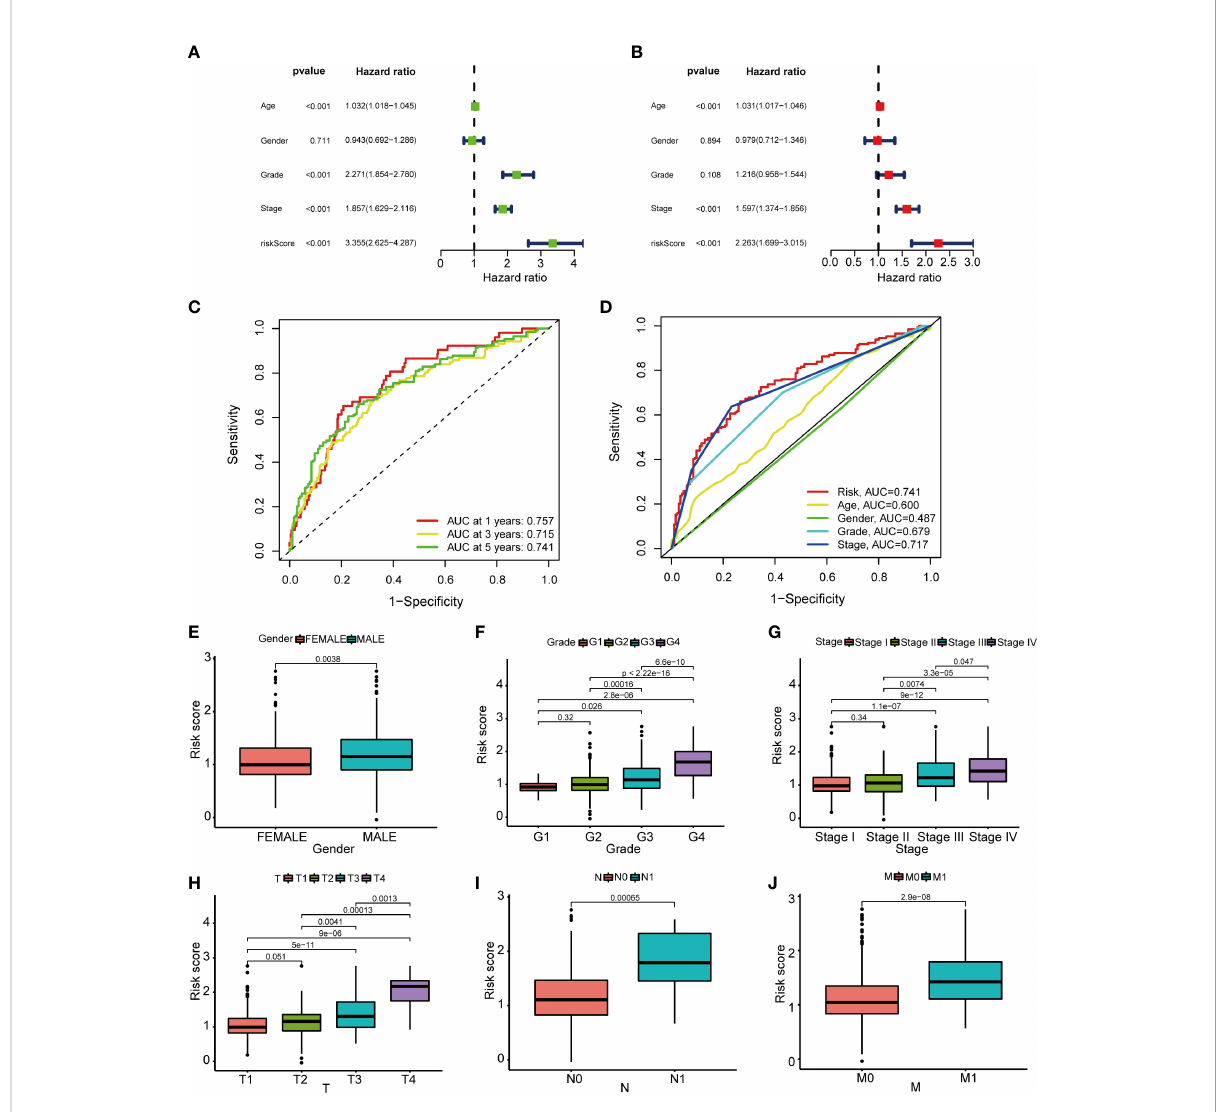
FIGURE 5 The prognostic value of the basement membrane score combined with pathological features in the TCGA cohort. (A, B) . The multi-Cox-reg and uni-Cox-reg analyses of the risk score and clinical variables in association with overall survival. (C, D) . The 1-, 3-, and 5-year ROC curves were plotted to indicate the association of the risk scores with clinical characteristics. (E – G) . The relationship of pathological features [that ’ s gender (E) , grade (F) , TNM stage (G) , tumor invasion (H) , lymphoid metastasis (I) , and distal metastasis (J) ] with risk